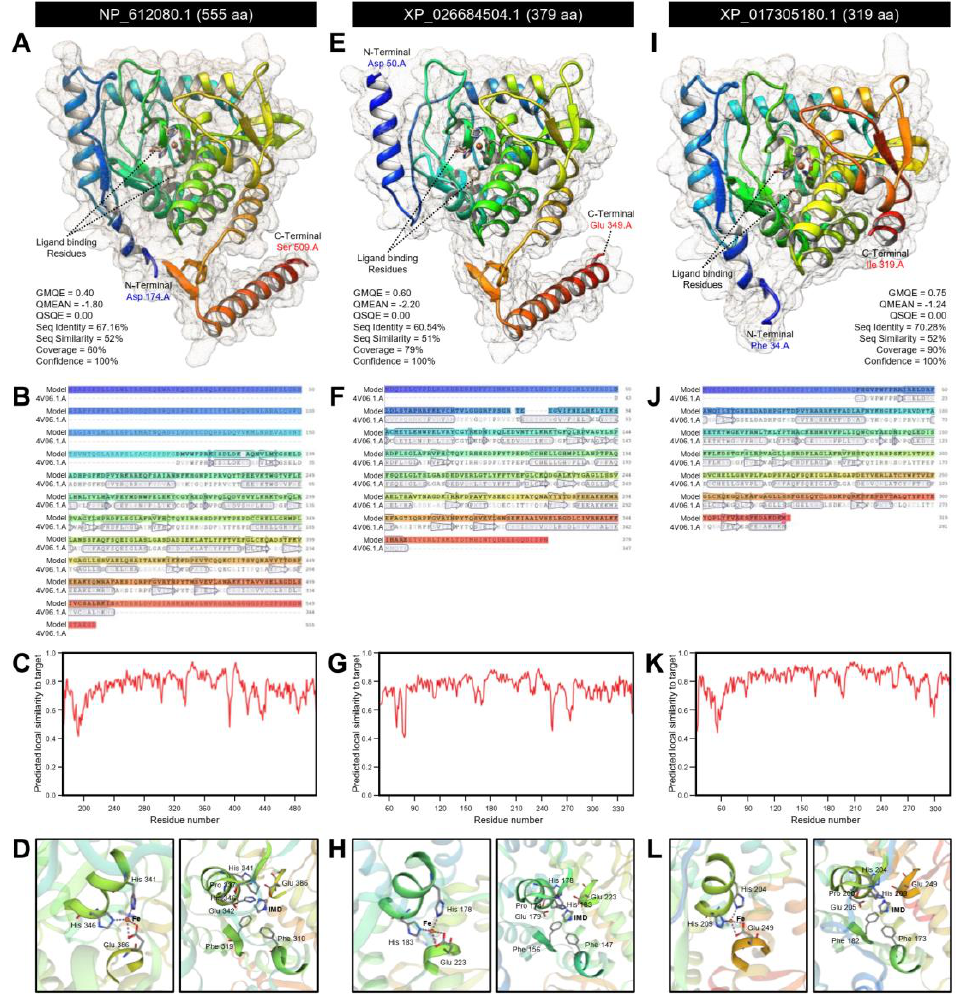
Figure 2. The crystallographic three-dimensional (3D) modeling of tryptophan 5-hydroxylase ( DcT5H ) of Diaphorina citri . ( A , E , I ) The predicted three-dimensional (3D) structure model and its associated mesh surface of DmT5H (NP_612080.1), DcT5H -1 (XP_026684504.1), and DcT5H -2 (XP_017305180.1), respectively. The tertiary structures were predicted with 100.0% confidence by the single highest scoring template of the crystal structure of human tryptophan 5-hydroxylase 2 (also known as tryptophan hydroxylase 2; TPH2), catalytic domain (Protein Data Bank (PDB ID): 4v06.1.A), and refined to 2.63 Å resolution. Protein chains are colored according to the rainbow color spectrum, from blue (N-terminus) to red (C-terminus). ( B , F , J ) Model–template alignment of DmT5H , DcT5H -1, and DcT5H -2, respectively. AA sequences of each model were aligned with the template (4v06.1.A). Secondary structures are represented by rectangles ( α -helices) and arrows ( β -sheets). Matched sequences are indicated in black. ( C , G , K ) Local quality estimate of the predicted models of DmT5H , DcT5H -1, and DcT5H -2, respectively. ( D , H , L ) Close-up of the ligand-binding site of DmT5H , DcT5H -1, and DcT5H -2, respectively. The selected poses were oriented to show the entry point for iron (Fe) and imidazole (IMD). Some surrounding AA near to the ligand are shown with their residue number. All bioinformatics analyses were carried